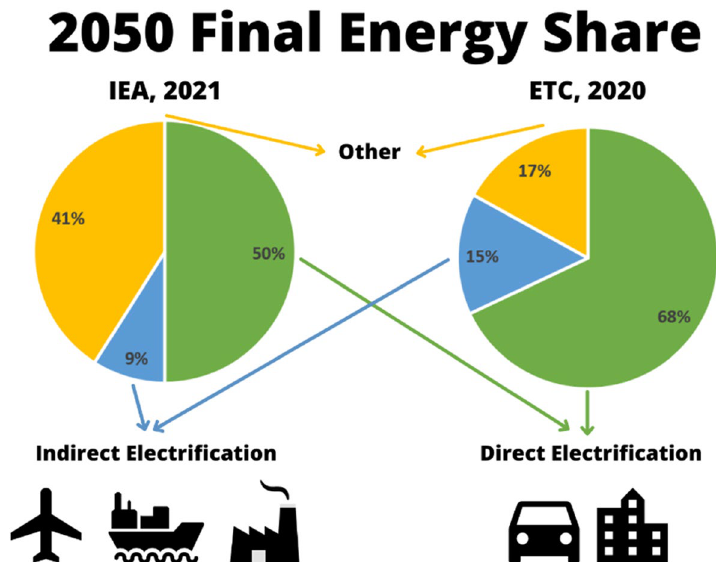
Fig. 1 Comparison of projected final energy shares in 2050 for IEA and ETC net zero emission scenarios. Author